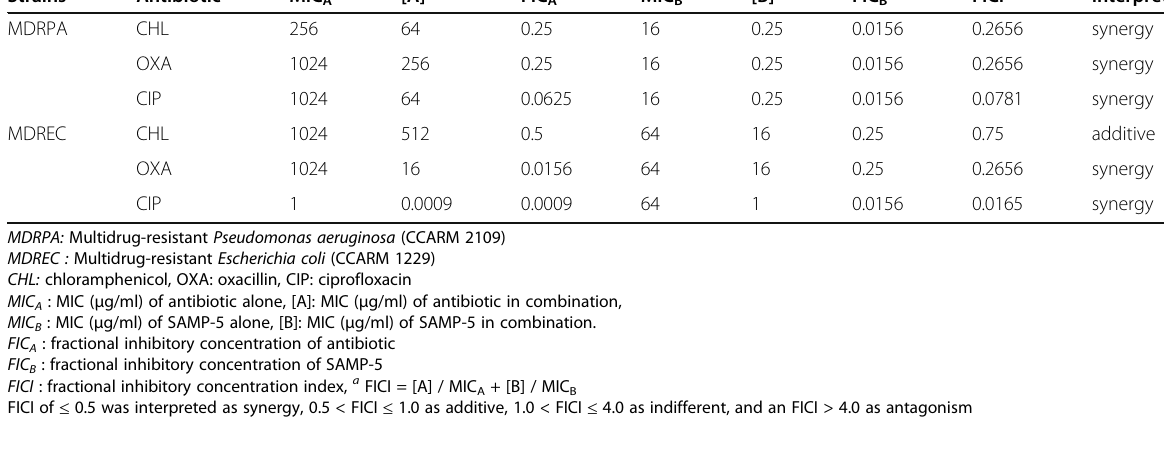
Table 2 Synergy between SAMP-5 and conventional antibiotics against MDRPA and MDREC Strains Antibiotic